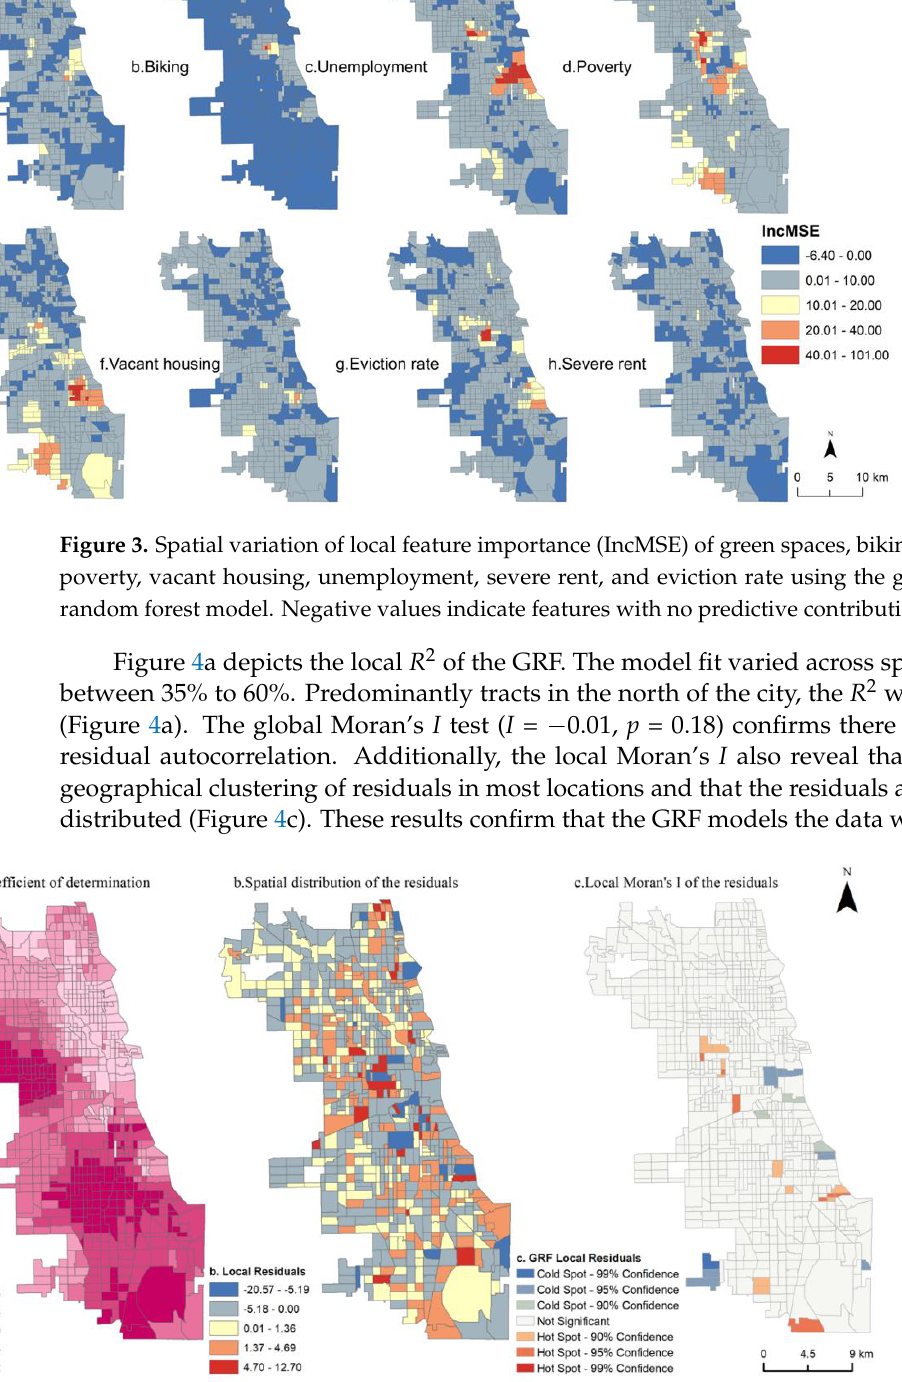
Figure 4. ( a ). Local coefficient of determination ( R 2 ). ( b ). Spatial distribution of the standardized local residuals. ( c ). Local Moran ’ s I of standardized residuals.